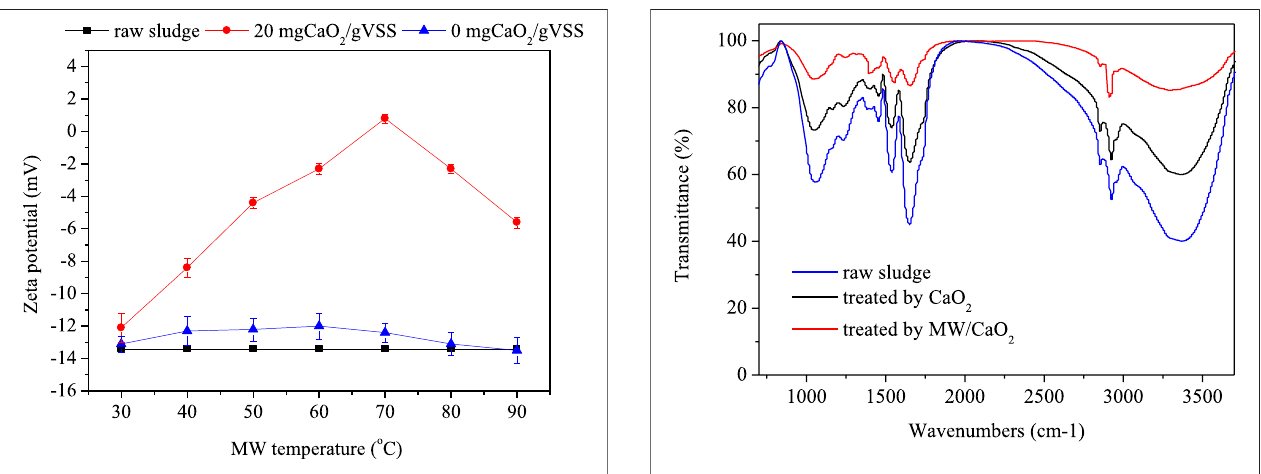
FIGURE 6 | The effect of CaO 2 and MW temperatures on zeta potential.